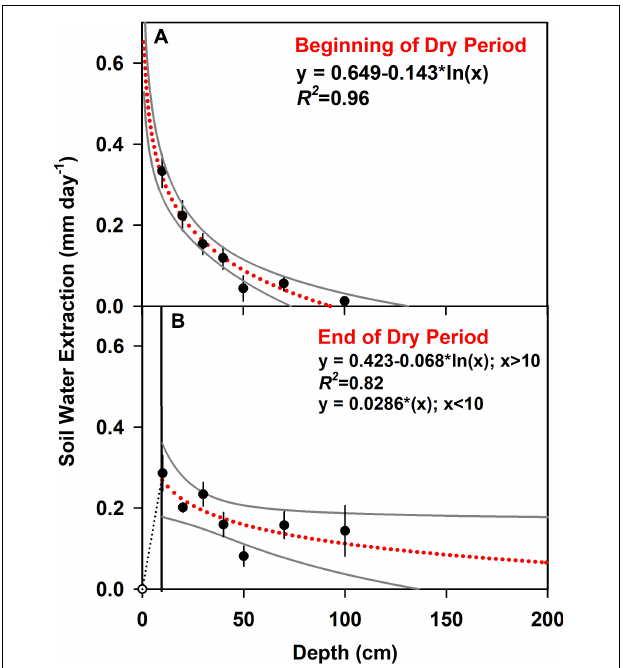
FIGURE 6 | Soil water extraction is modeled as a logarithmic function of soil depth, with 95% confidence interval in gray. Points represent the average of actual measurements, with standard error bars. The beginning of the dry period (A) was September 16 and the end of the dry period (B) was October 16, 2018. As the soil surface was dry at the end of the drought, we assumed water extraction from 0 to 10 cm increased linearly with soil depth (reference Table 3 for integrated daily rates).